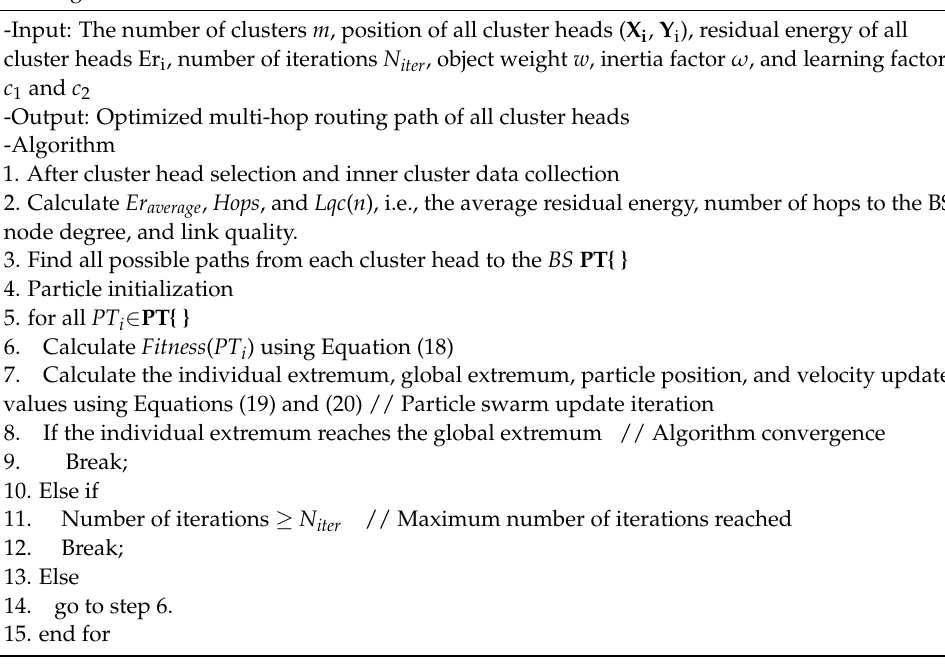
Algorithm 2: Pseudo code for the proposed multi-hop routing method based on an improved PSO algorithm.